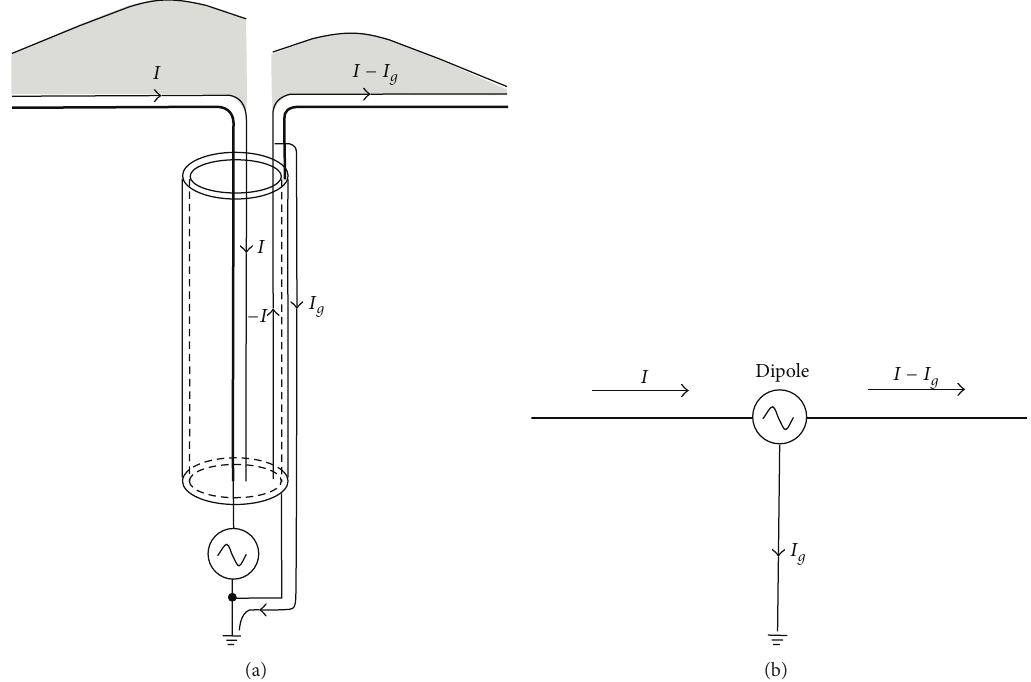
Figure 4: Current paths for a dipole fed by a coaxial line without a balun: (a) dipole antenna excited directly by a coaxial line without using a balun and (b) equivalent circuit of the radiating antenna arms.